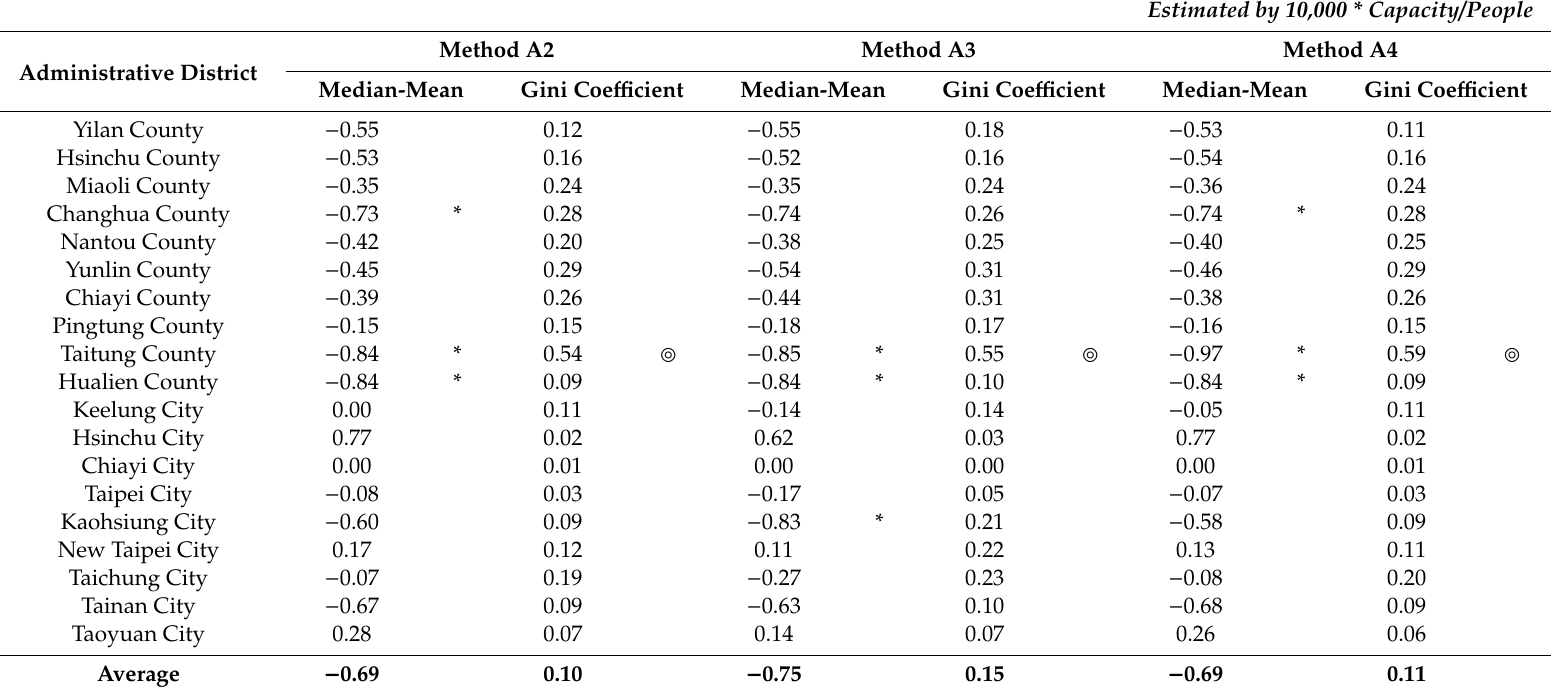
Estimated by 10,000 * Capacity /